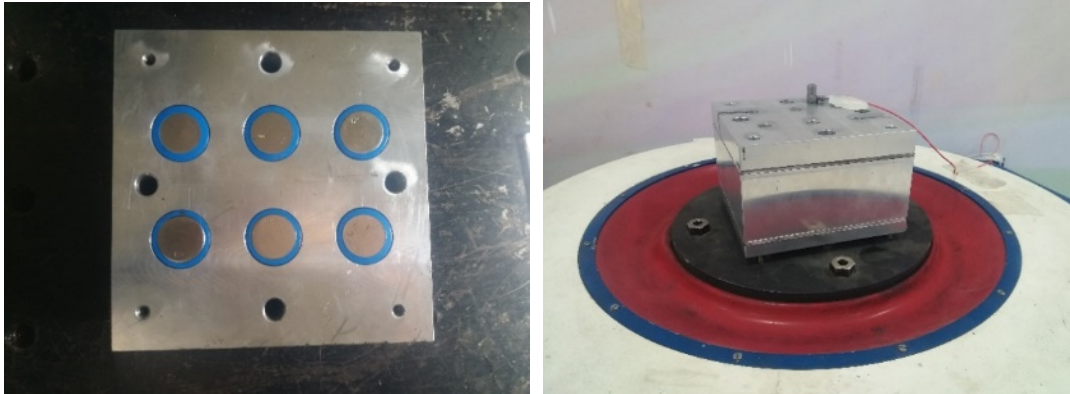
Figure 1. Vibration test fixture and setup.